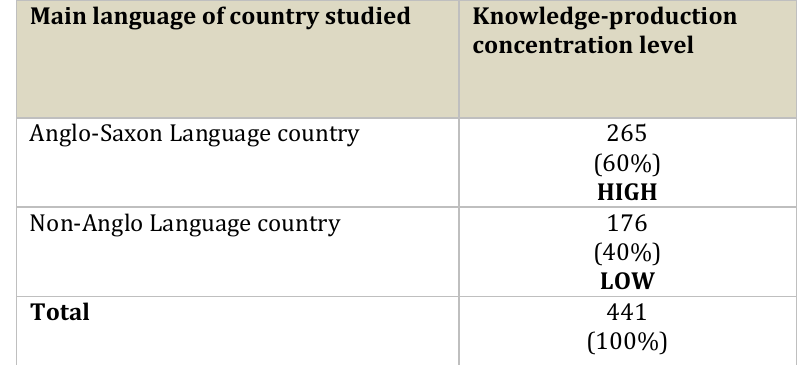
Table 5: Level of knowledge-production concentration in Crimes of the powerful studies in linguistic terms (Anglo language/non- Anglo language) according to studied country’s main lang uage in WoS Core Collection search (n=441)